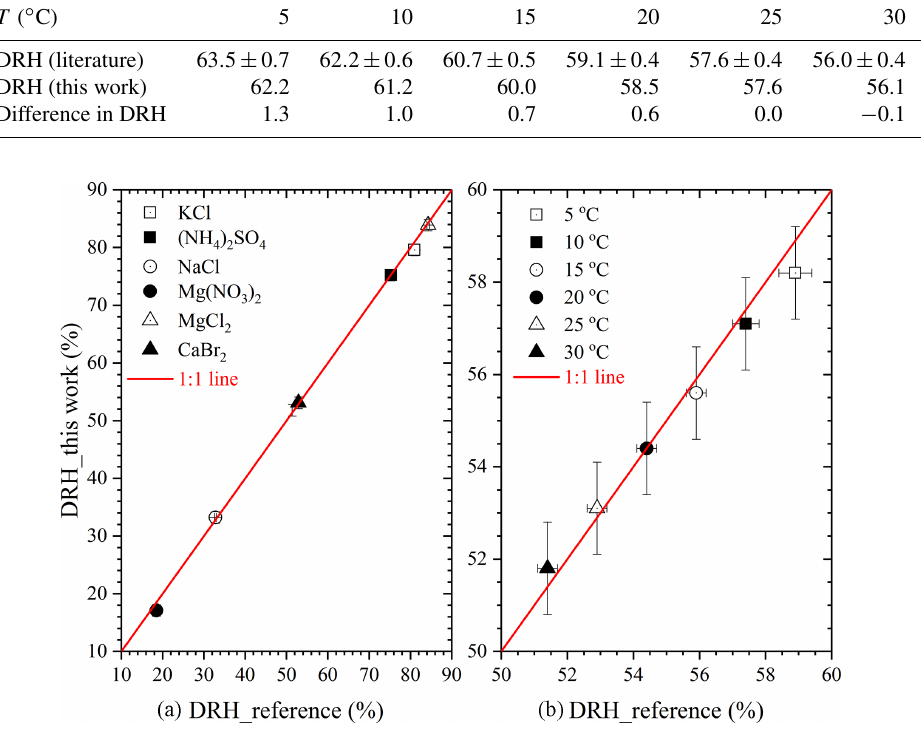
Figure 4. Comparison of our measured and previous reported DRHs (Greenspan, 1977). (a) DRHs of ( NH 4 ) 2 SO 4 , NaCl, MgCl 2 · 6H 2 O, Mg ( NO 3 ) 2 · 6H 2 O, CaBr 2 , and KCl at 25 ◦ C. Please note that error bars are included, but they are too small to be clearly visible. (b) DRHs of Mg ( NO 3 ) 2 · 6H 2 O as a function of temperature from 5 to 30 ◦